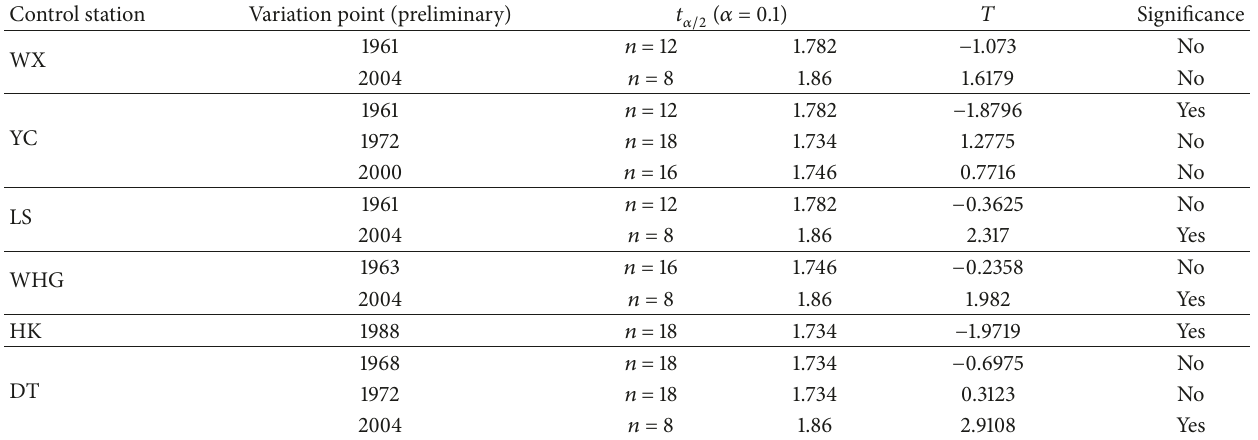
Table 5: The runoff 𝑡 -test result table.